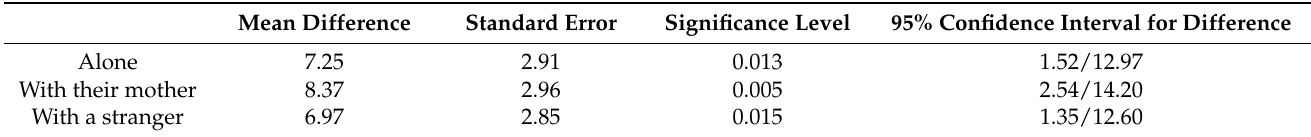
Figure 2. Pressure pain thresholds for each group (children with CP vs. healthy children) at the three social support situations (alone, with their mother, or with a stranger). Results are displayed as mean ± TE. ANOVA: * p < 0.05. Table 2. Statistical pairwise comparisons of pressure pain thresholds for each group (children with CP vs. healthy children) at the three social support situations (alone, with their mother, with a stranger).